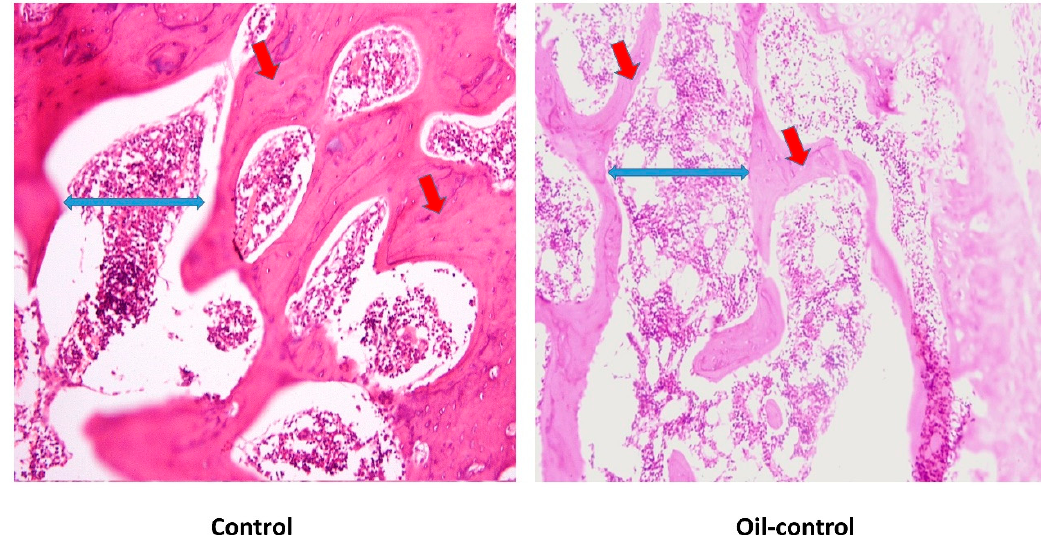
Figure 2. Comparison of histological sections of rat’s femur from control group ( A ) vs. Oil-control group ( B ) at the end of the study. Red arrows are plotting the osteoid area and the blue ones referring to the trabecular separation.